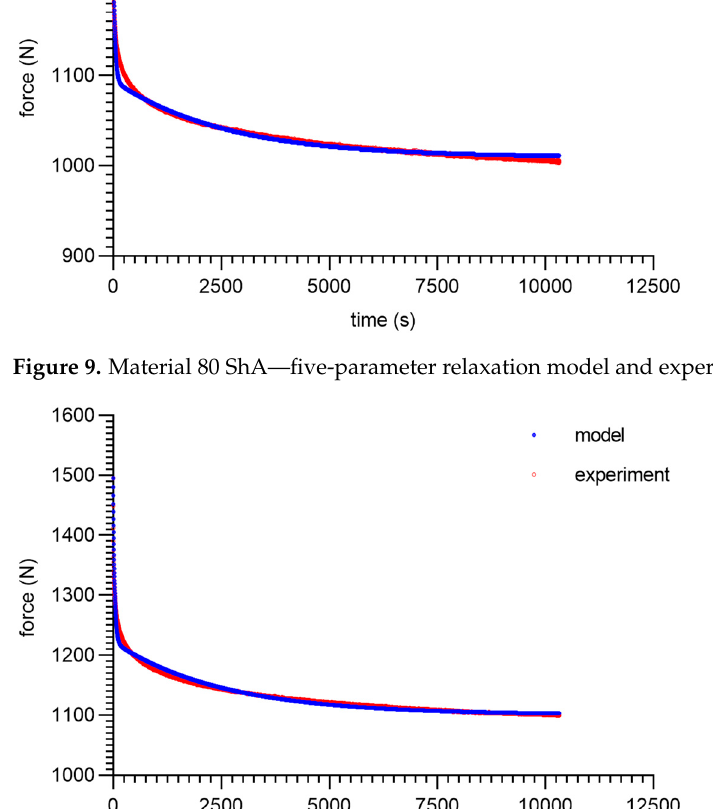
Figure 10. Material 80 ShA—five-parameter relaxation model and experimental data for ε = 75%.